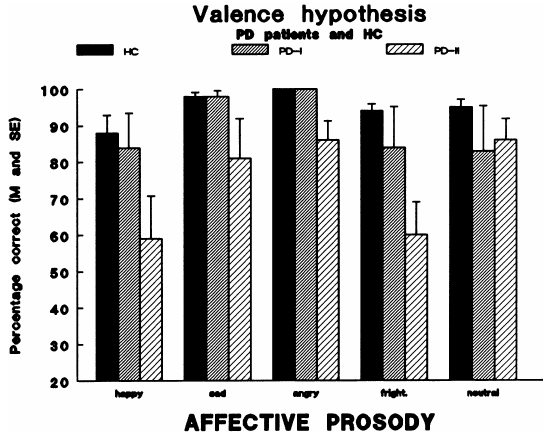
Fig. 3. Figure 3: Percentage correct (mean and standard error) for single emotional categories in the affective prosody subtests of the PD patient groups and healthy controls (PD - I=patients with PD in the early phase; PD-II = patients with PD in more advanced stage; HC = healthy controls; fright. =